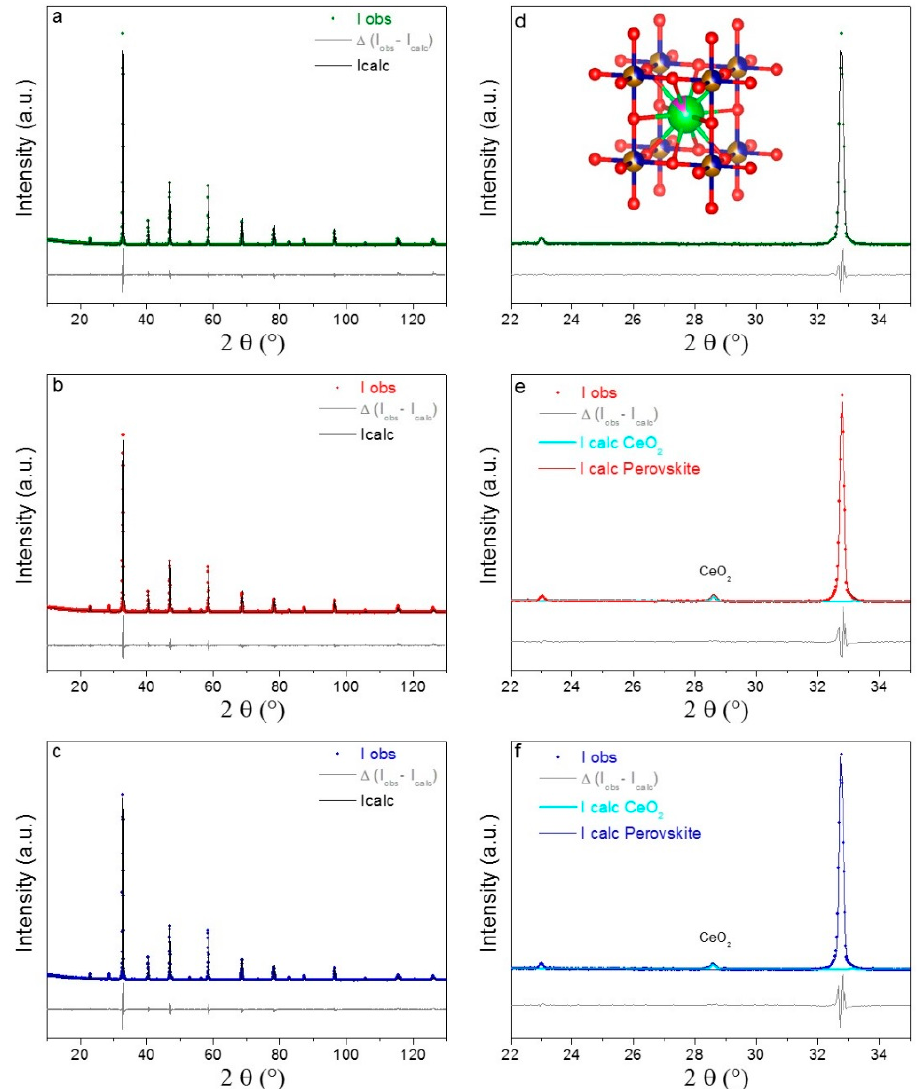
Figure 2. ( a – c ) Graphical Rietveld refinement of XRD patterns for the three examined samples; ( d – f ) enlargement of the graphical Rietveld fit in the angular range 22–35° with image of the refined perovskite structure in d (Sr and Ce are green and pink, Fe and Co are gold and blue, O is red) and indication of the CeO 2 phase formation in e and